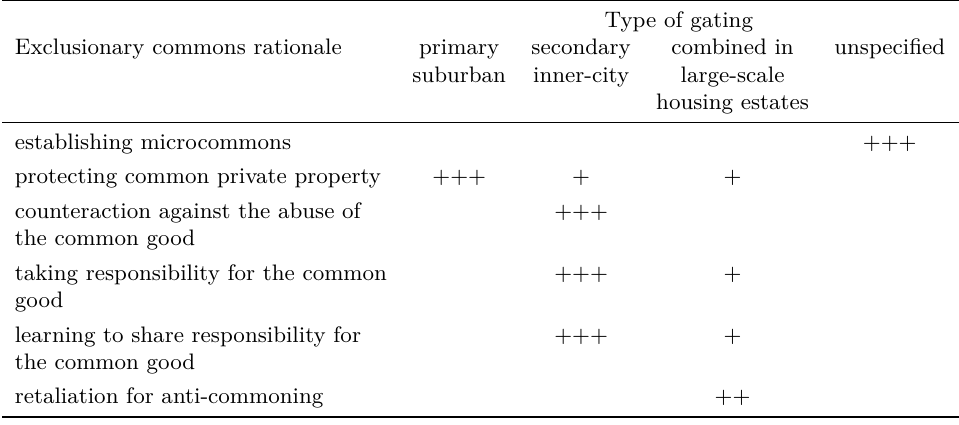
Table 1: Rationalisation of exclusionary commoning in different types of